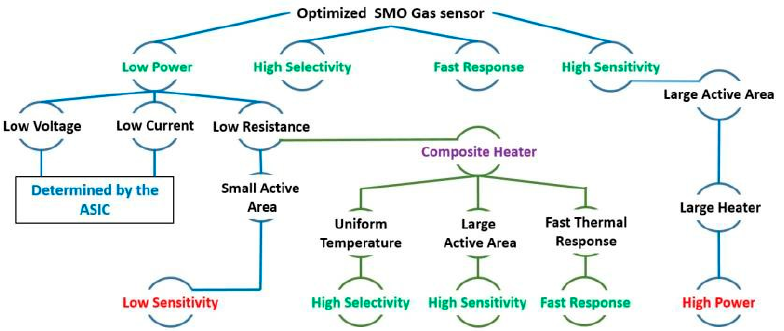
Figure 1. Limitations and required elements to enhance the sensing capability and performance of SMO gas sensors.